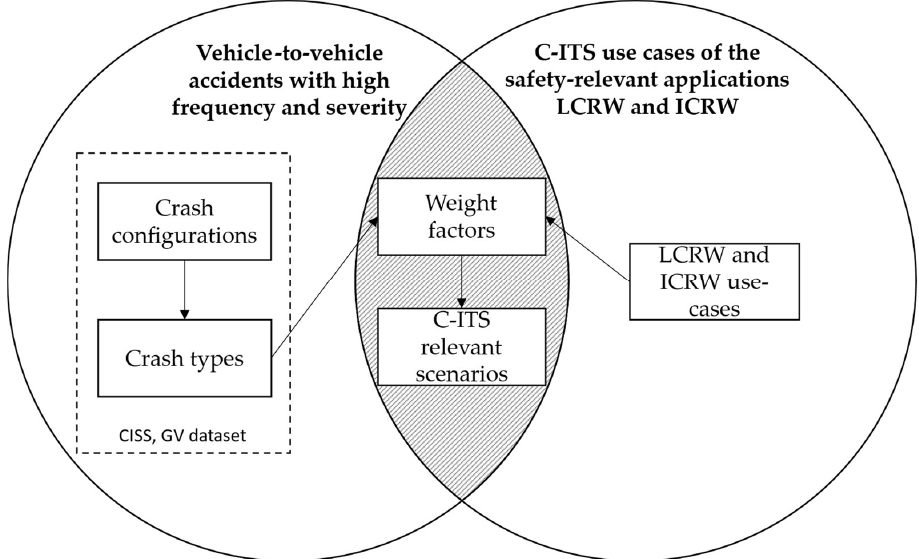
Figure 1. Schematic representation of the methodological approach for determining the C-ITS rele- vant scenarios. relevant